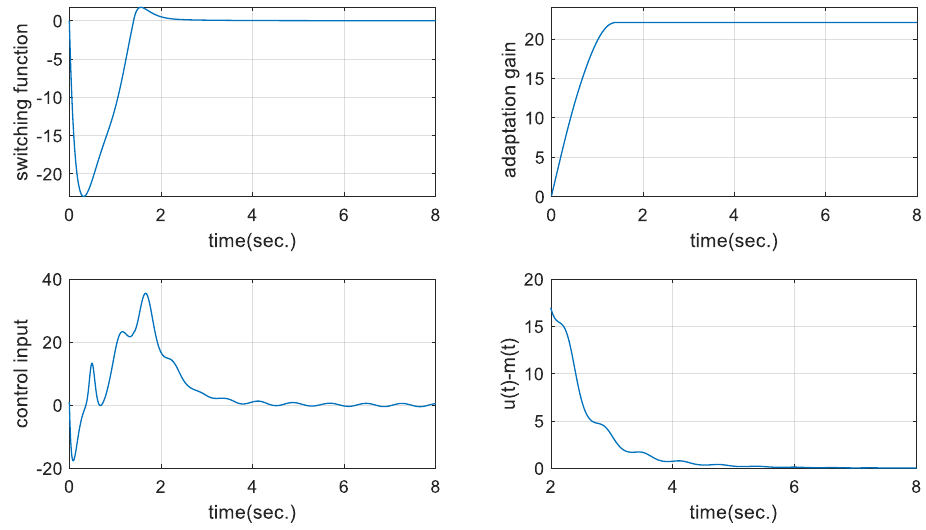
( t ) , adaptation gain ˆ ρ ( t ) , continuous control